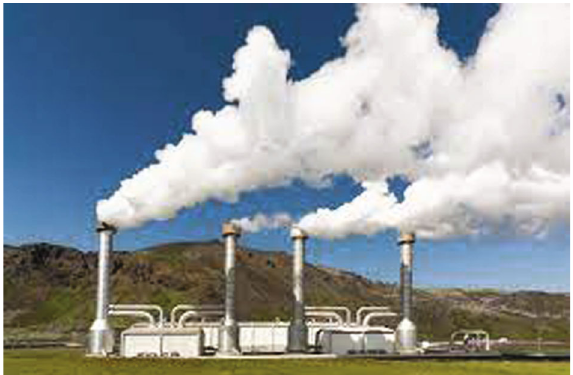
Figure 3: Source of geothermal energy.